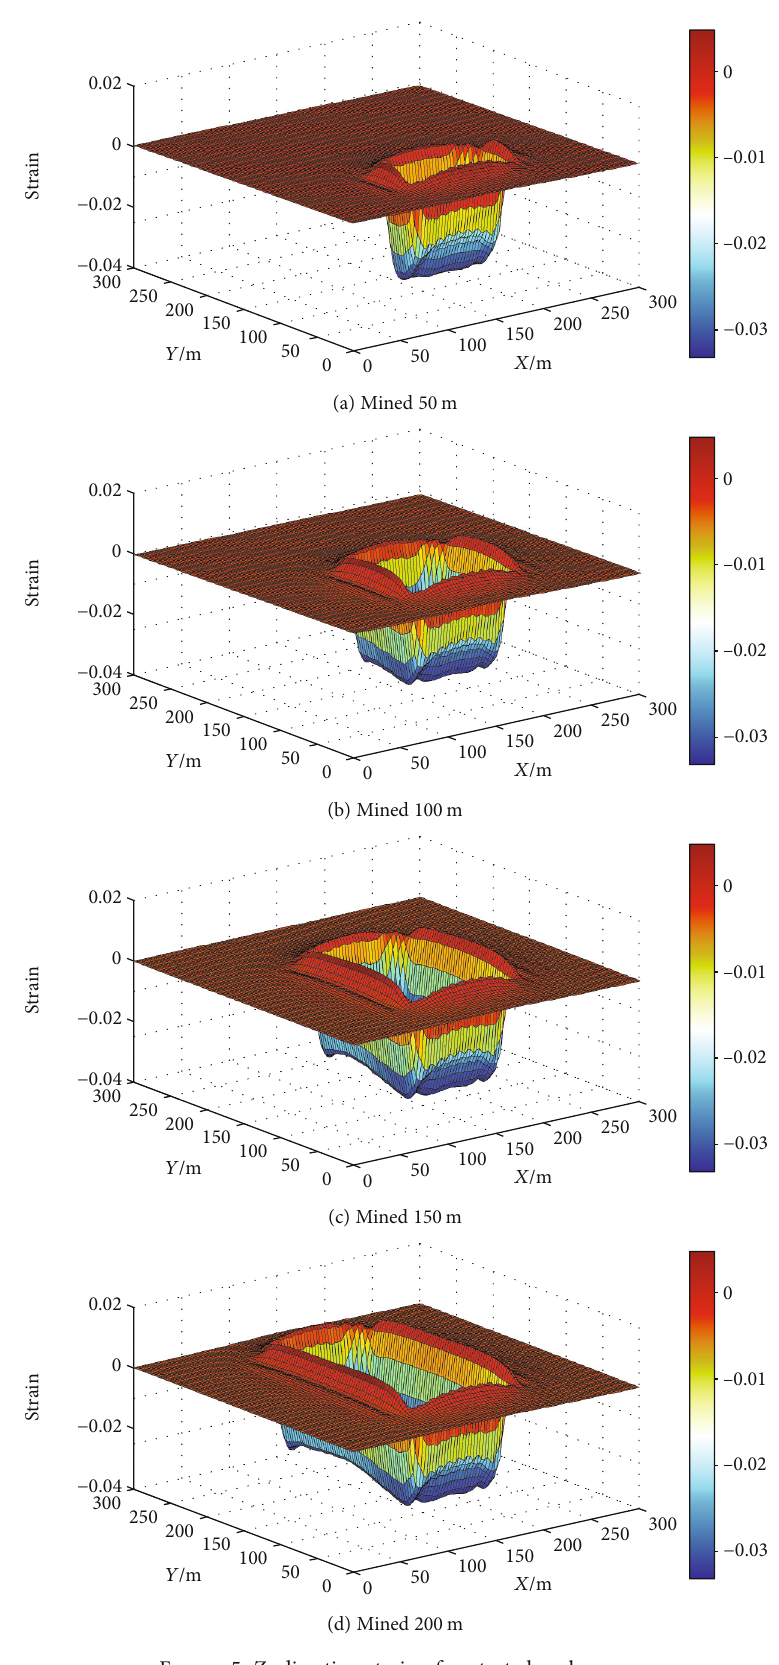
Figure 5: Z - direction strain of protected coal